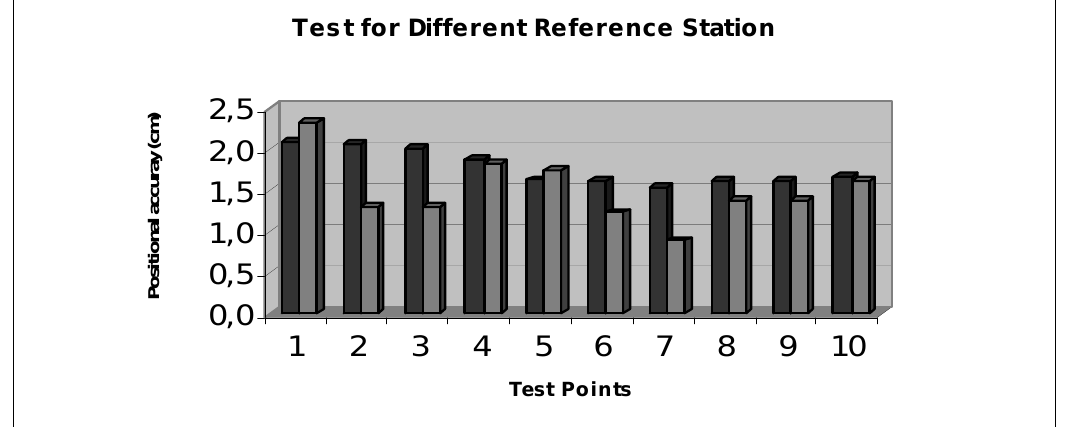
Figure 5 . Positional accuracies for Case